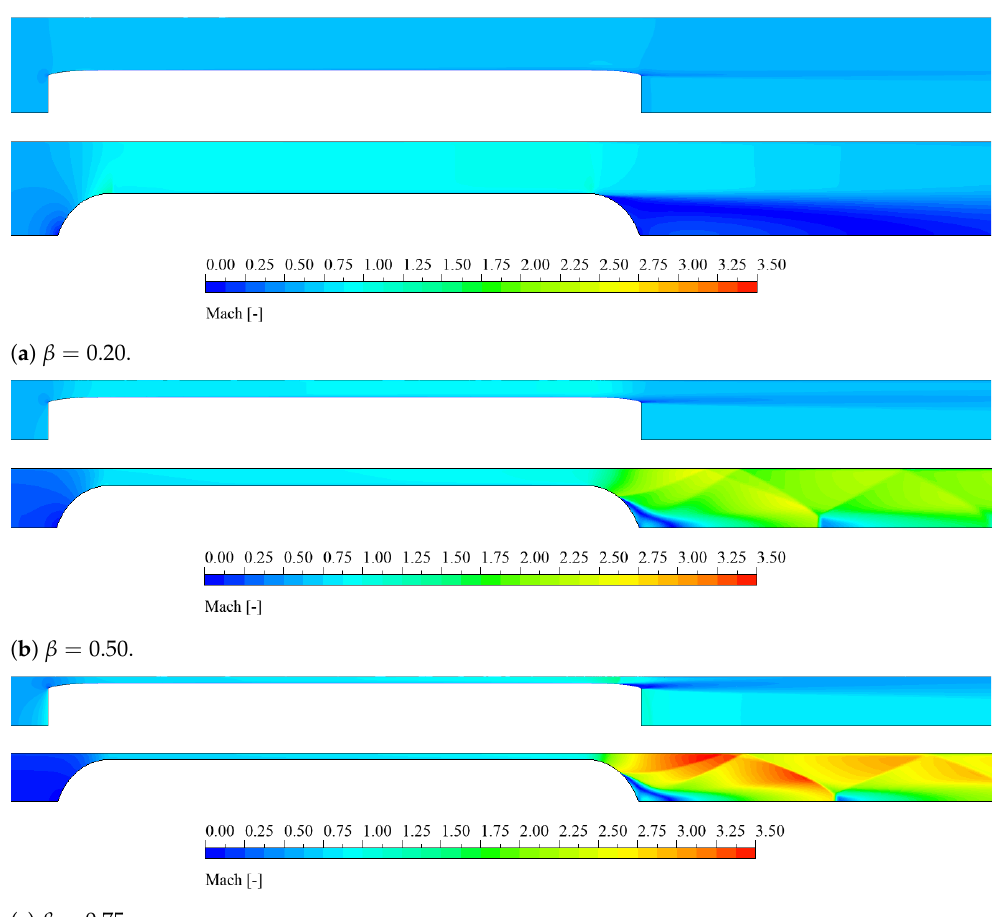
Figure 12. Comparison of the Mach contour for the compressor case ( upper figure ) and the base case ( lower figure ), for 700 km/h and different blockage